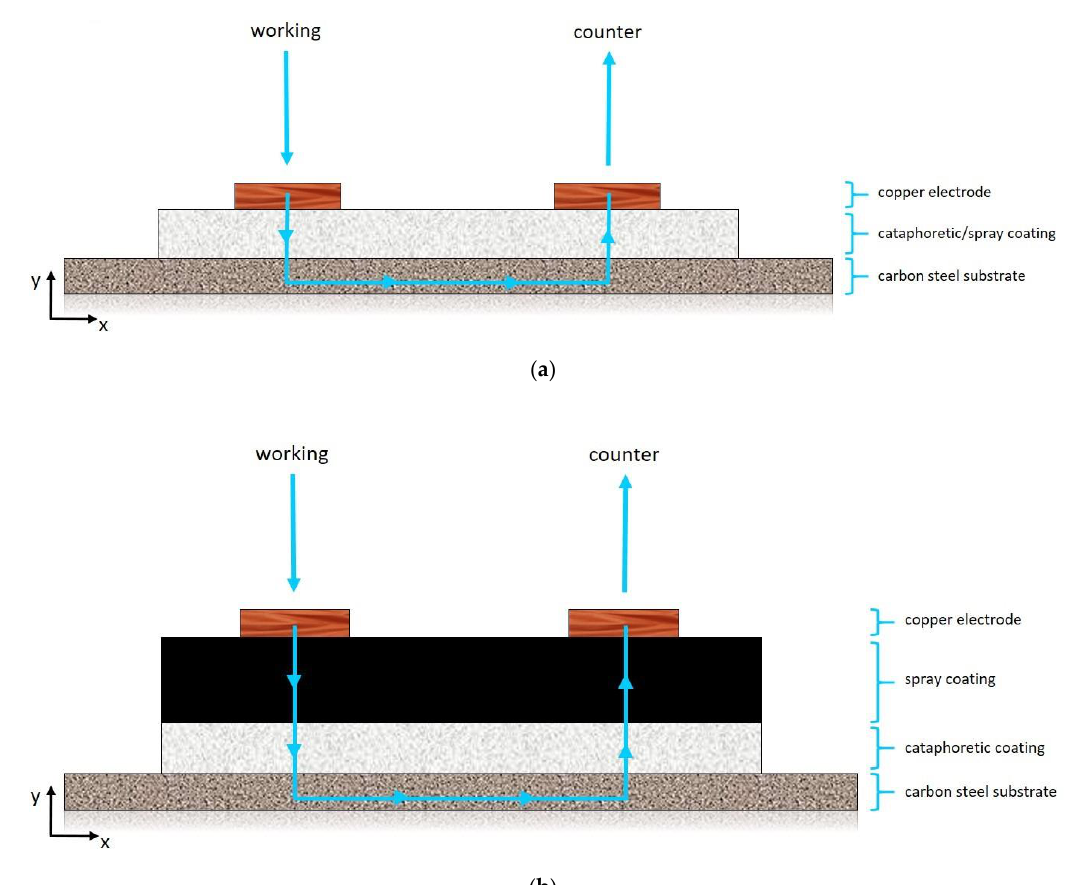
Figure 13. Conductivity measurement setup [cross view] for single ( a ) and double ( b ) layer coatings.